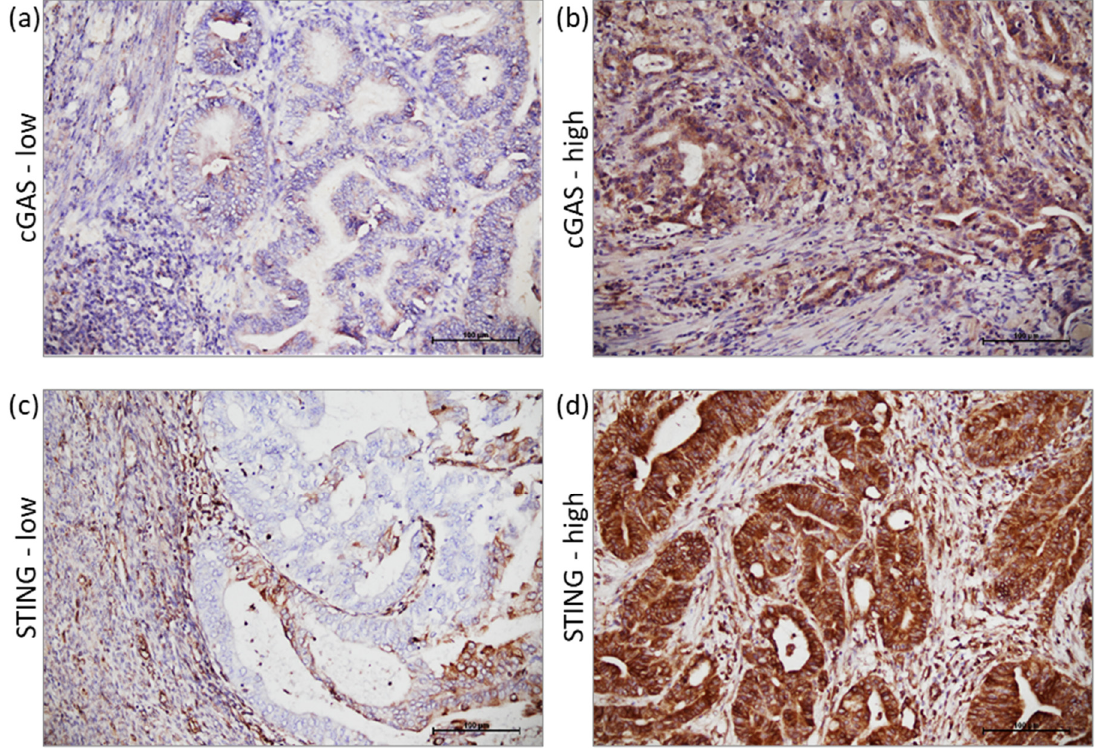
Figure 1. cGAS and STING immunostaining. Representative histologic images of low and high ex- pression of cGAS ( a ) and ( b ) and STING ( c ) and ( d ), respectively. expression of cGAS ( a ) and ( b ) and STING ( c ) and ( d ),